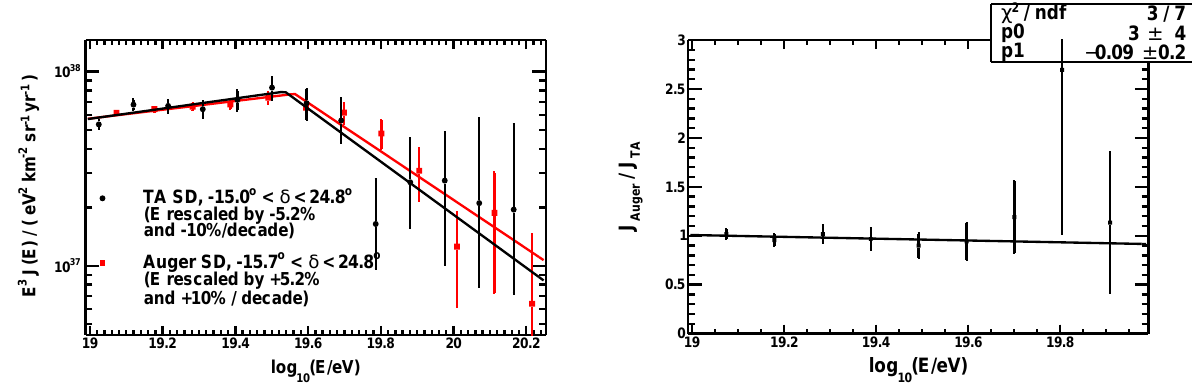
Figure 3. (left) TA and Auger spectra in the common declination band after applying additional energy-dependent energy corrections to TA and Auger. In addition to overall + 5.2% (Auger) and -5.2% (TA) energy scale corrections, TA and Auger energies were corrected by + 10% / decade (Auger) and -10% / decade (TA) starting at 10 EeV. (right) After these rescalings of the energies, the TA and Auger spectra are in excellent